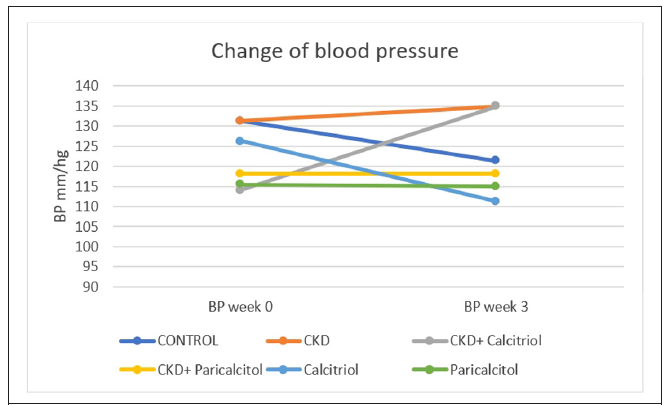
Figure 2. Change in blood pressure.